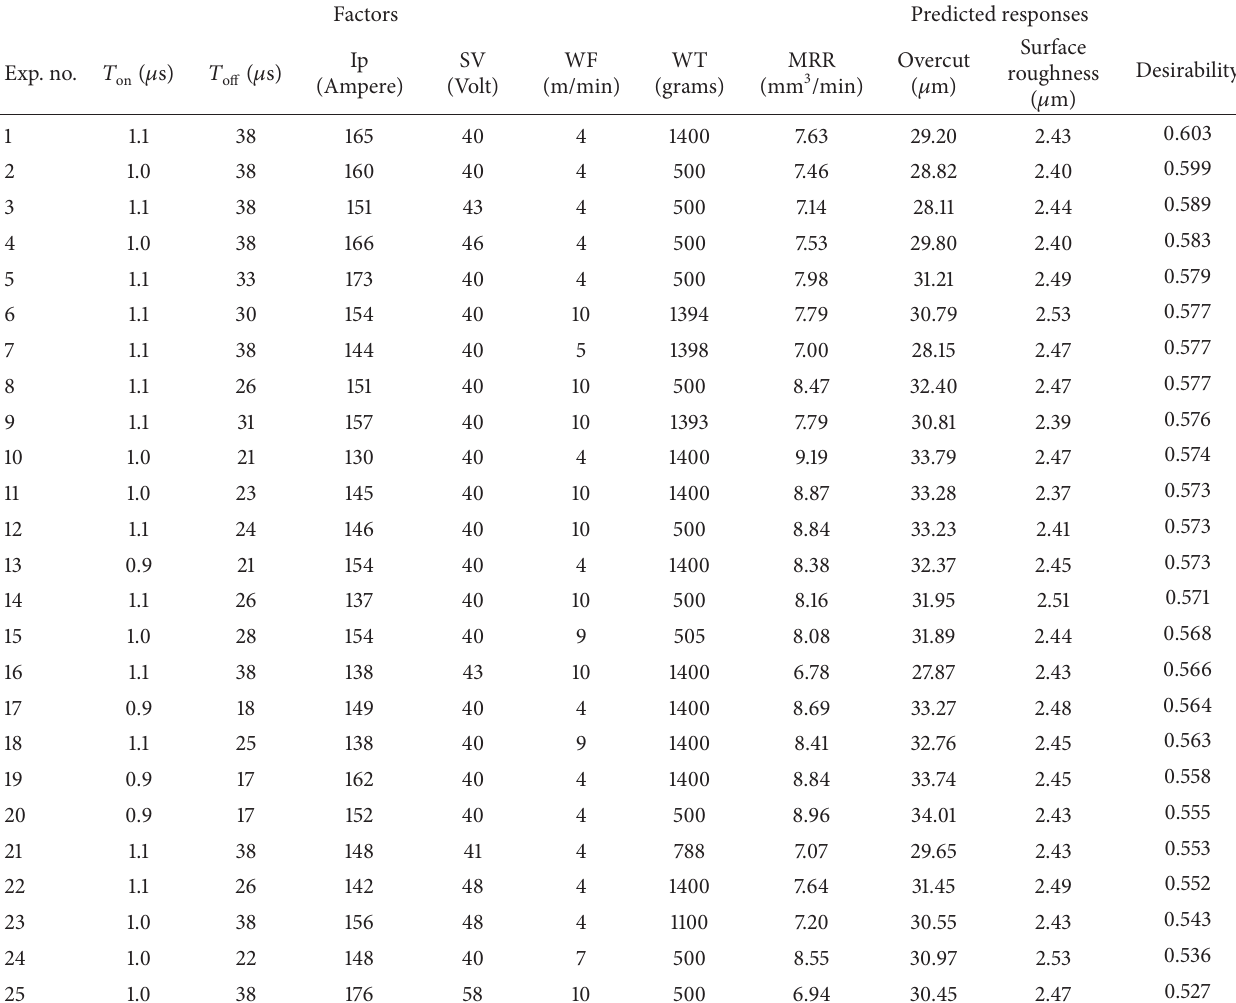
Table 8: Process parameters combinations for high value of desirability. Factors